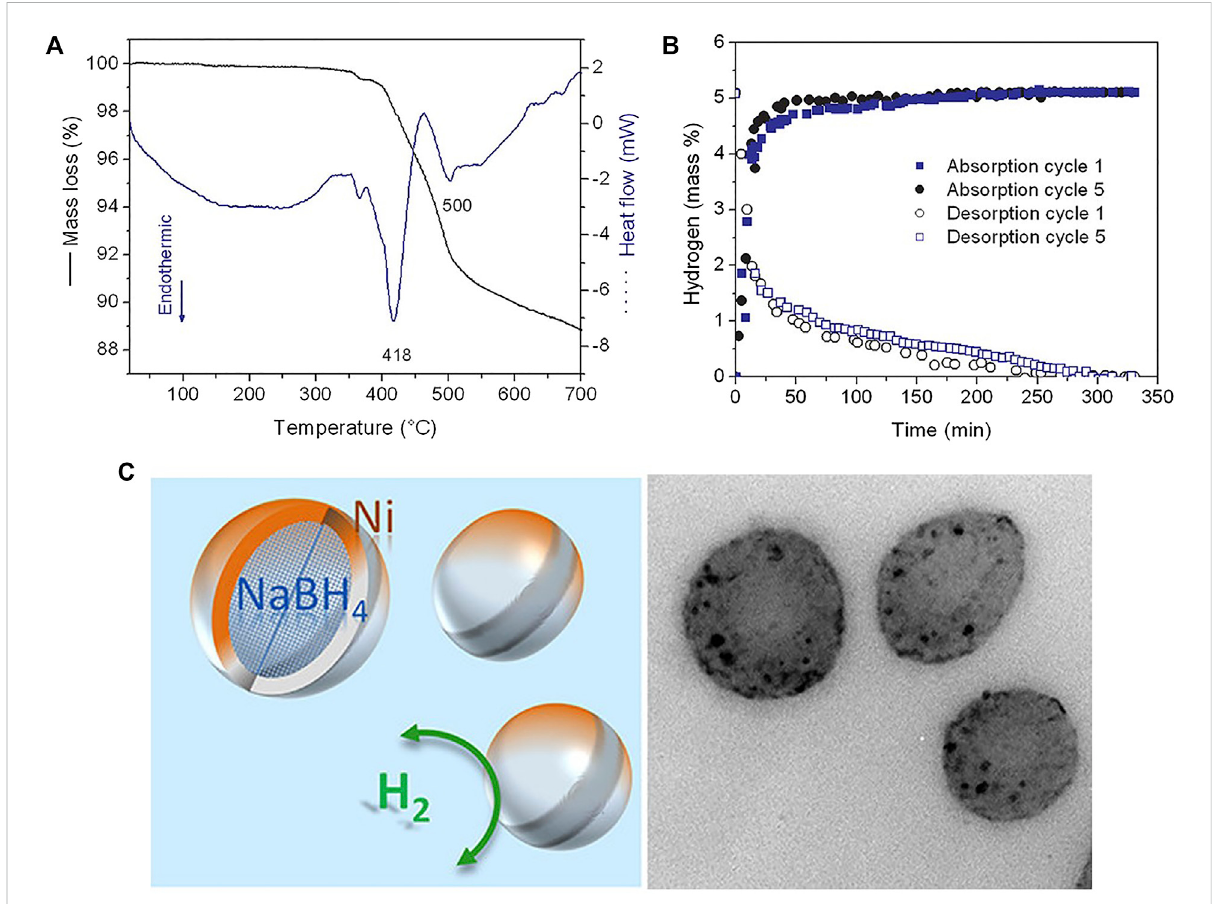
FIGURE 5 TGA/DSC curves (A) andisothermalhydrogendesorptioncurvesat350 ° C (B) ofthenanocon fi nedNaBH 4 . (C) ModelsandTEMimageoftheNi- doped nanocon fi ned NaBH 4 (Christian and Aguey-Zinsou,